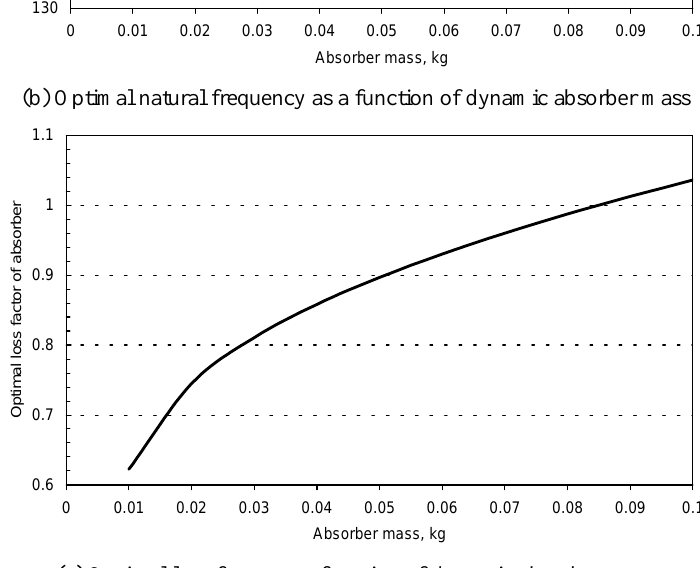
(c) Optimal loss factor as a function of dynamic absorber mass Fig. 4. Performance and optimal parameters of dynamic absorber at different absorber masses. a) Optimal overall acceleration as a function of dynamic absorber mass; b) Optimal natural frequency as a function of dynamic absorber mass; c) Optimal loss factor as a function of dynamic absorber